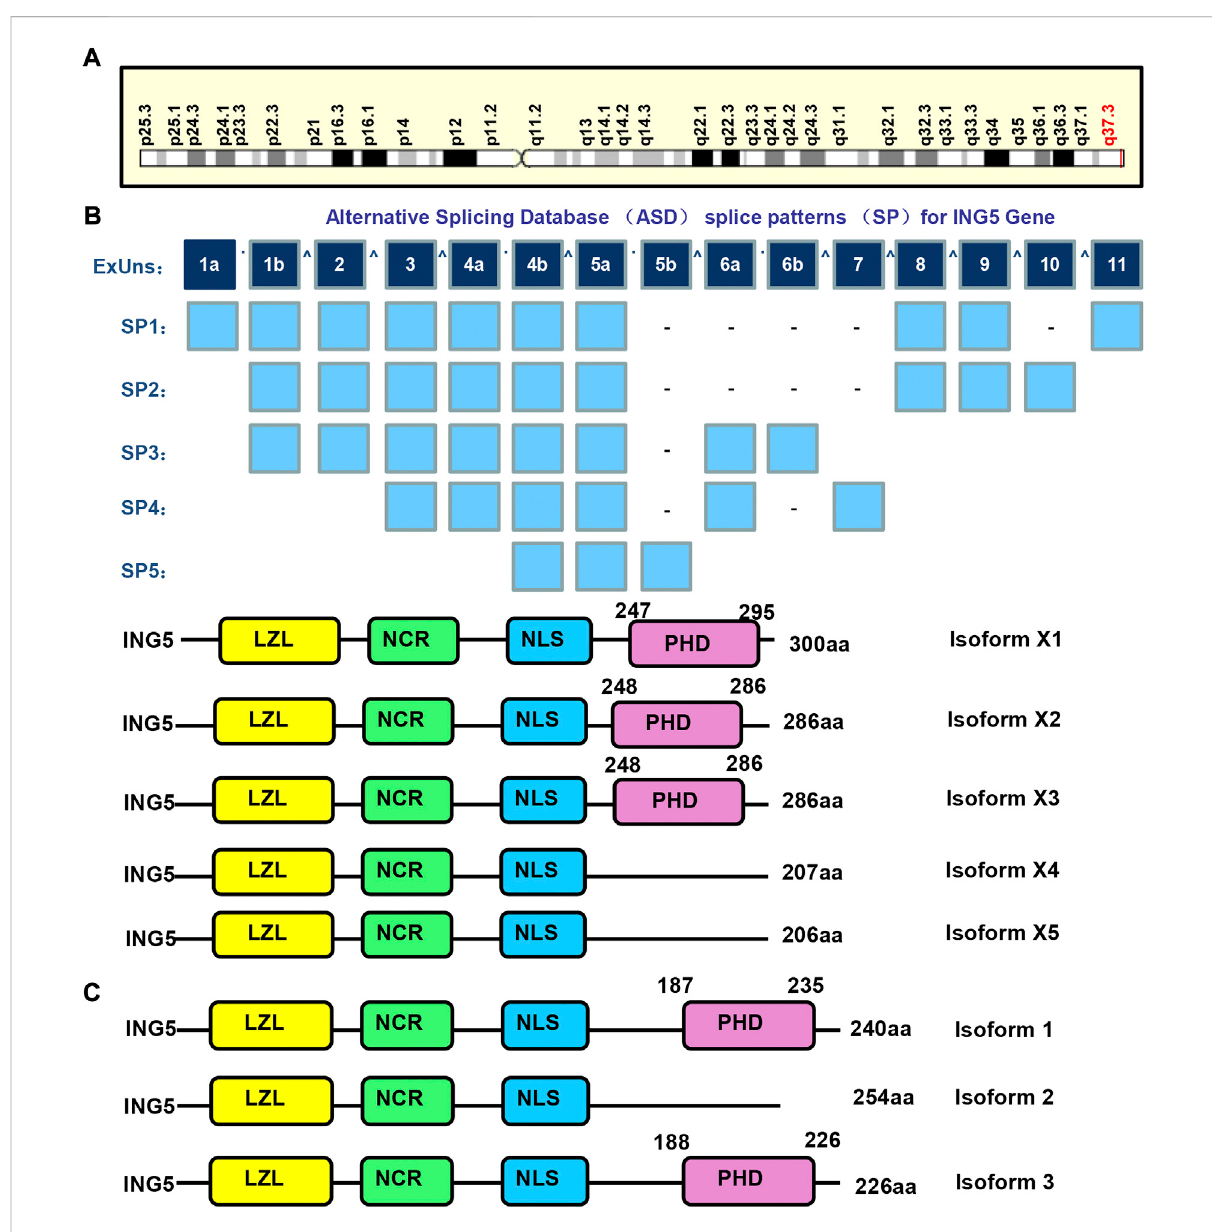
FIGURE 1 The structures of ING5 gene and protein. ING5 is localized in human chromosome 2q37.3 (A) , and theoretically spliced into 5 forms and encodes 5 proteins (B) . The 3 isoforms of ING5 are produced according to Genbank (C) . LZL, leucine zipper-Like motif; NCR: novel conserved region; NLS, nuclear localization signal; PHD, plant